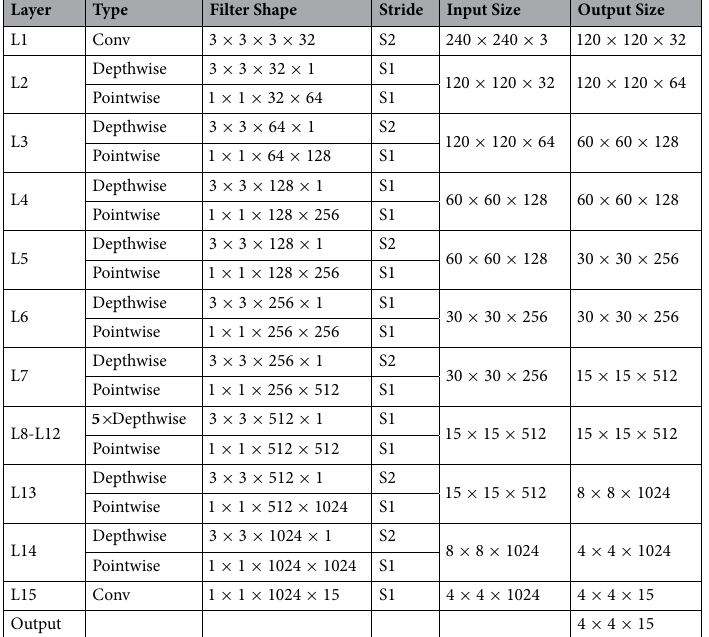
Table 1. On-board DNN Architecture. There is a Batch Normalization (BN) after each layer. The BNs are not shown for keeping the table